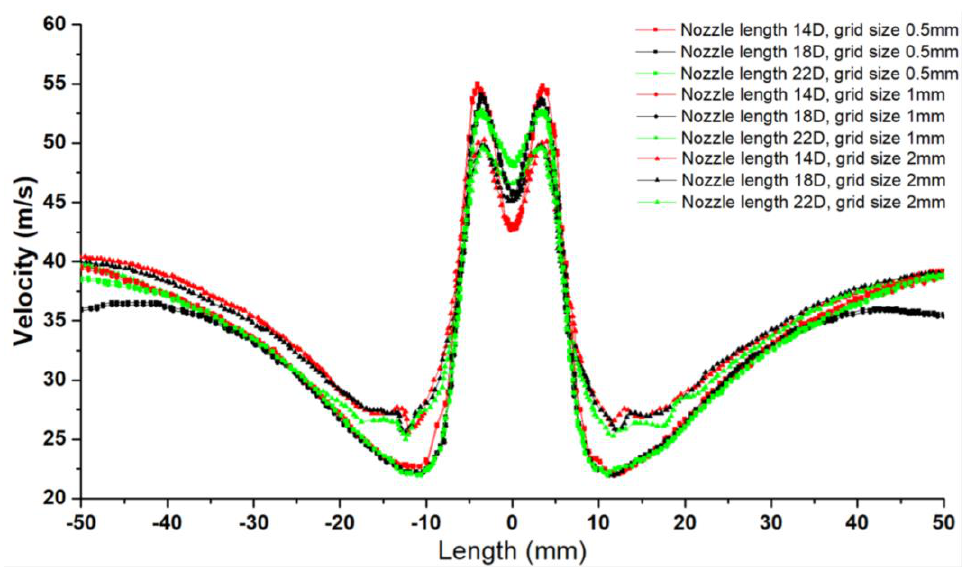
Figure 7. Velocity distributions at H/3 on the specimen surface at different nozzle lengths and grid sizes.